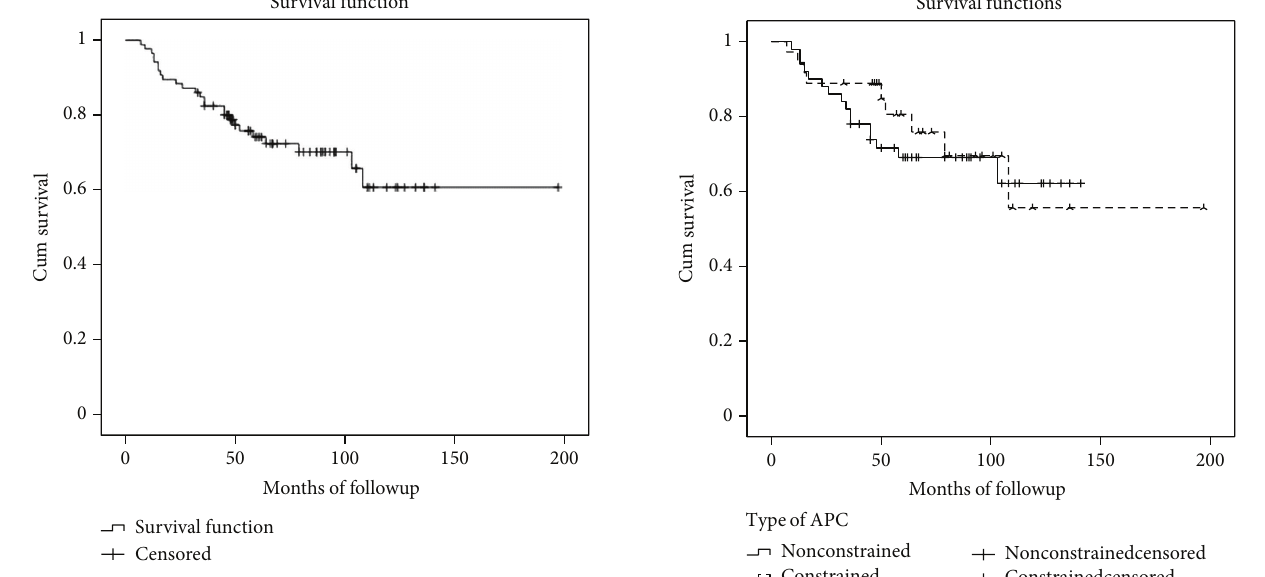
Figure 4: Kaplan-Meier curve showing the overall APC survival.